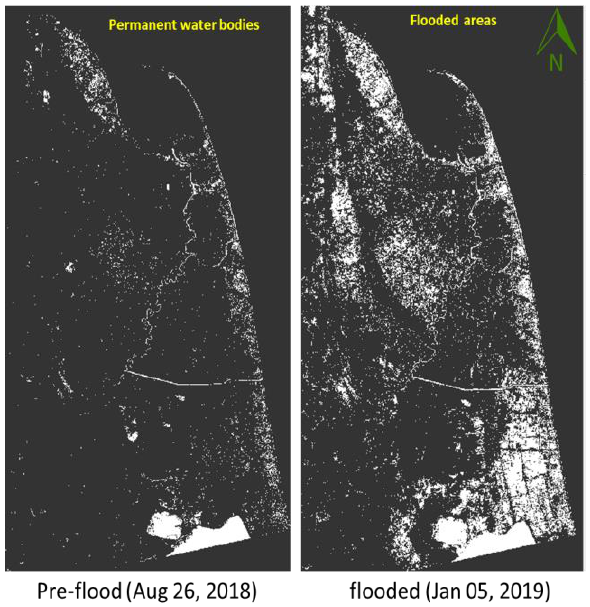
Figure 5. Results of change detection using